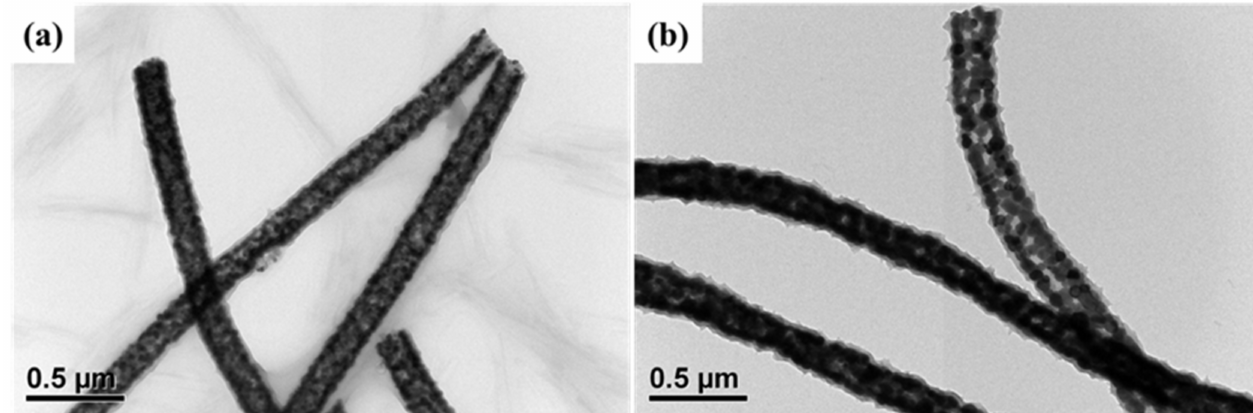
Figure 5. TEM images of ( a ) PANI/hollow In 2 O 3 nanofiber and ( b ) PANI/hollow C#In 2 O 3 nanofiber